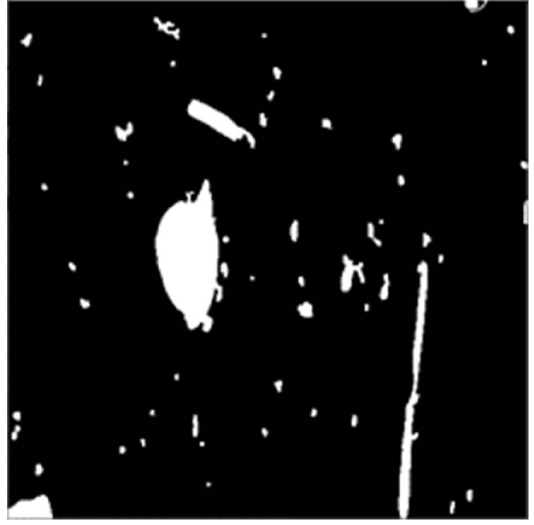
Figure 13. Threshold segmentation.